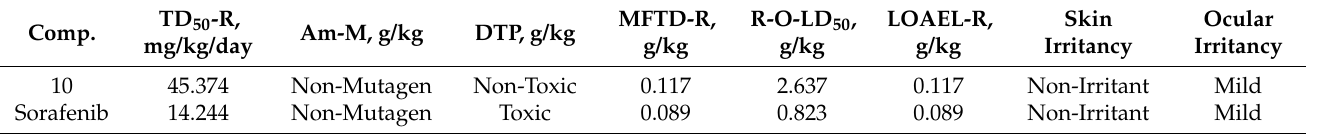
Table 3. In-silico toxicity studies of compound 10 and